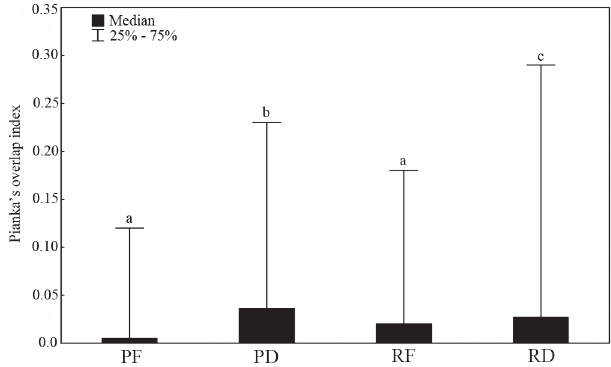
Fig. 4. Values of trophic niche breadth (mean±standard error) of fish species in each spatial- temporal units in the Cuiabá River basin, Mato Grosso State, Brazil. PF= Pond Flood; PD= Pond Drought; RF= River Flood; RD= River Drought. Trophic niche breadth was considered low (0-0.39), intermediate (0.4- 0.6) or high (0.61-1) (modified of Grossman, 1986).